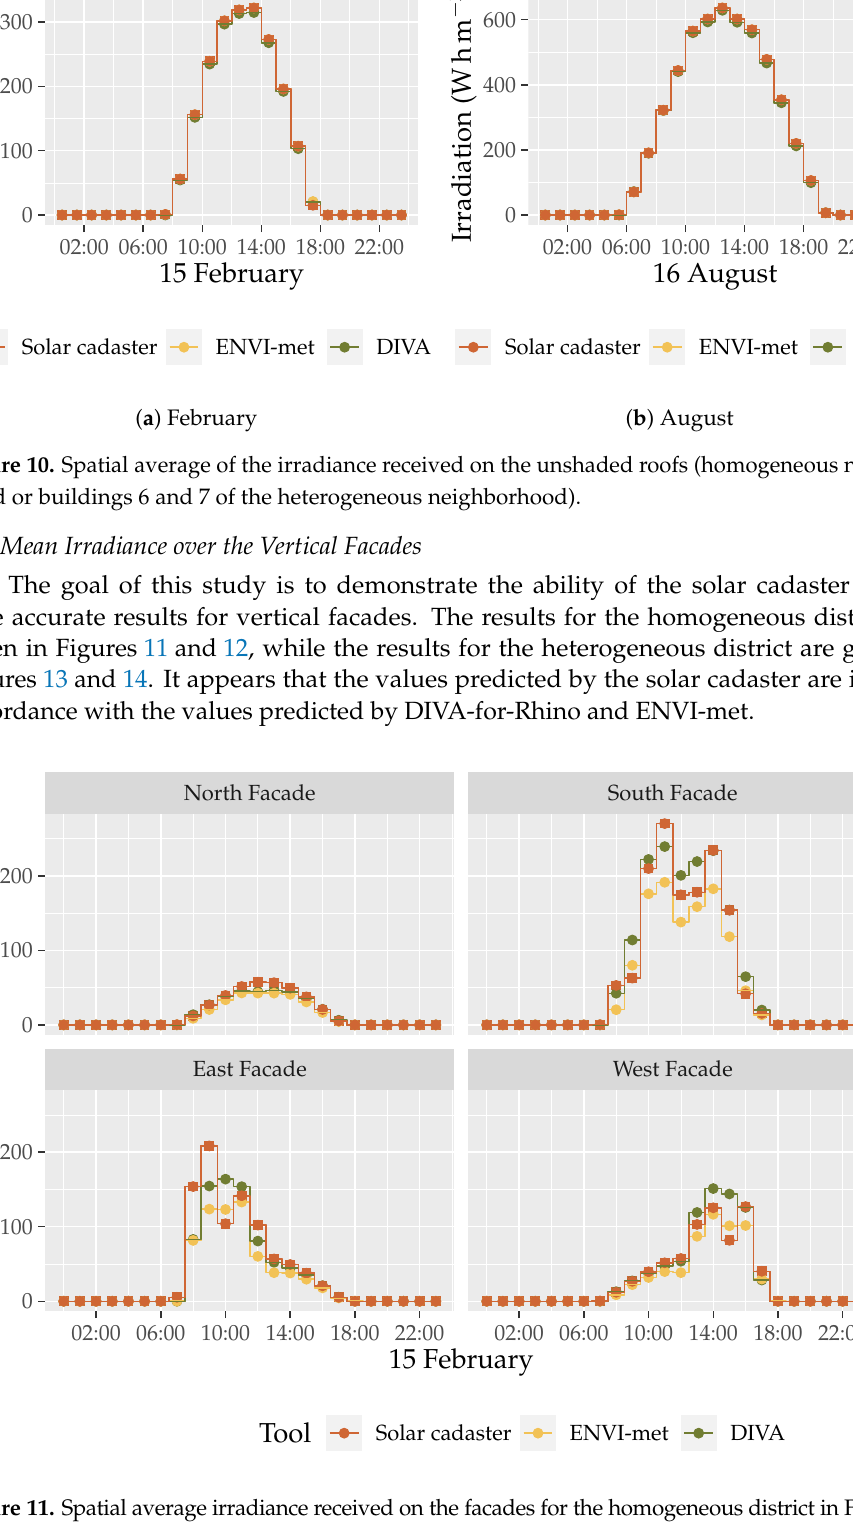
Figure 11. Spatial average irradiance received on the facades for the homogeneous district in